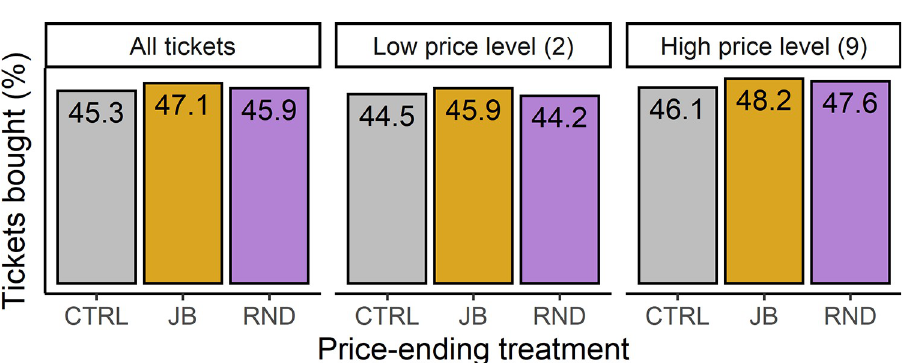
Fig 2. The main experiment results do not indicate a difference in purchasing rates (y-axis) for the three price- ending treatments. A: purchasing rates across both price levels. B: purchasing rates for the low price level. C: purchasing rates for the high price level. CTRL = control prices, JB = just-below prices, RND = rounded prices.